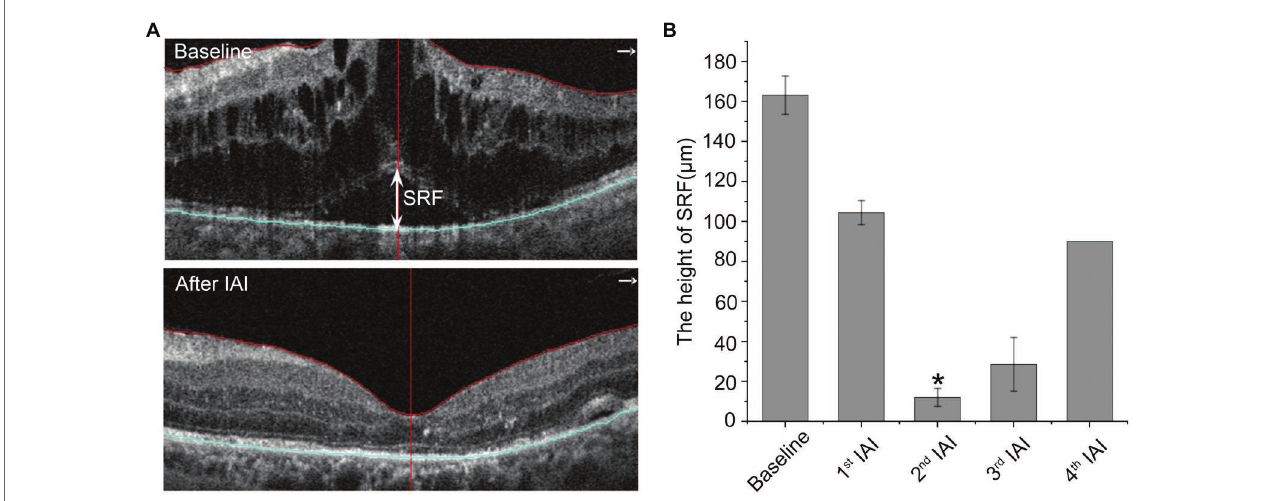
FIGURE 4 | The height of SRF is decreased after IAI. (A) Representative images of a 50-year-old male DME patient with SRF at baseline and after a monthly IAI. The double-head arrow indicates the SRF. (B) Decreased height of SRF following IAI. Data are mean ± SD. * p < 0.05 vs. baseline. SRF, subretinal fluid and IAI, intravitreal aflibercept injection.